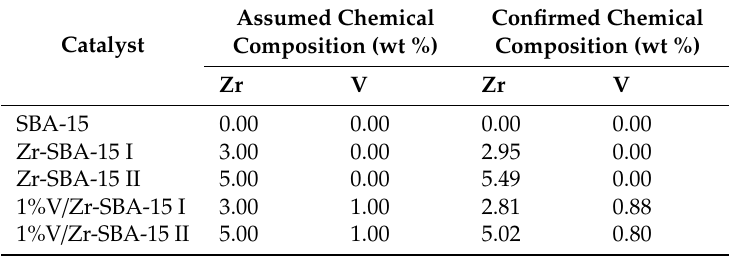
Table 1. Chemical Zr and V (wt %) composition by ICP-OES of all the synthesized materials.